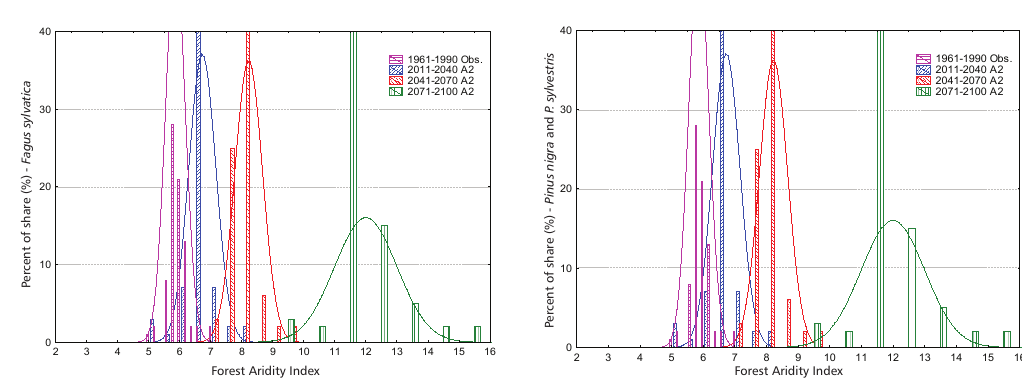
SEEFOR 5 (2): 117-124 121 © CFRI http://www.seefor.eu